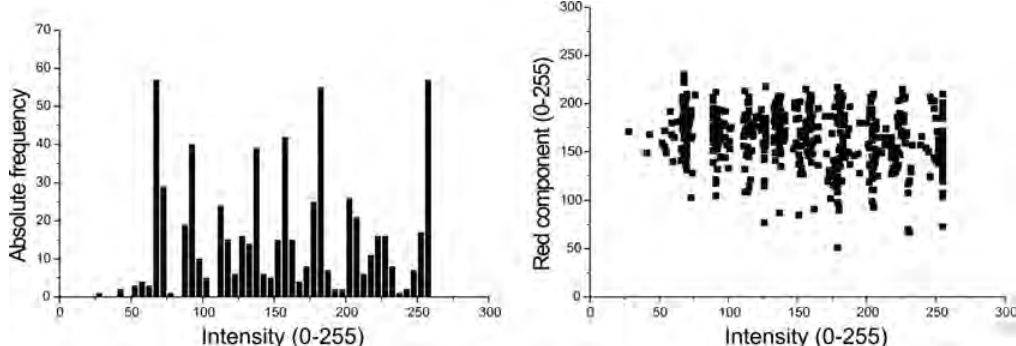
Fig. 4a,b. Statistical distribution of intensity data extracted from the vertical profile 3 (a), and plot of TLS-based intensity vs. red channel of the RGB image